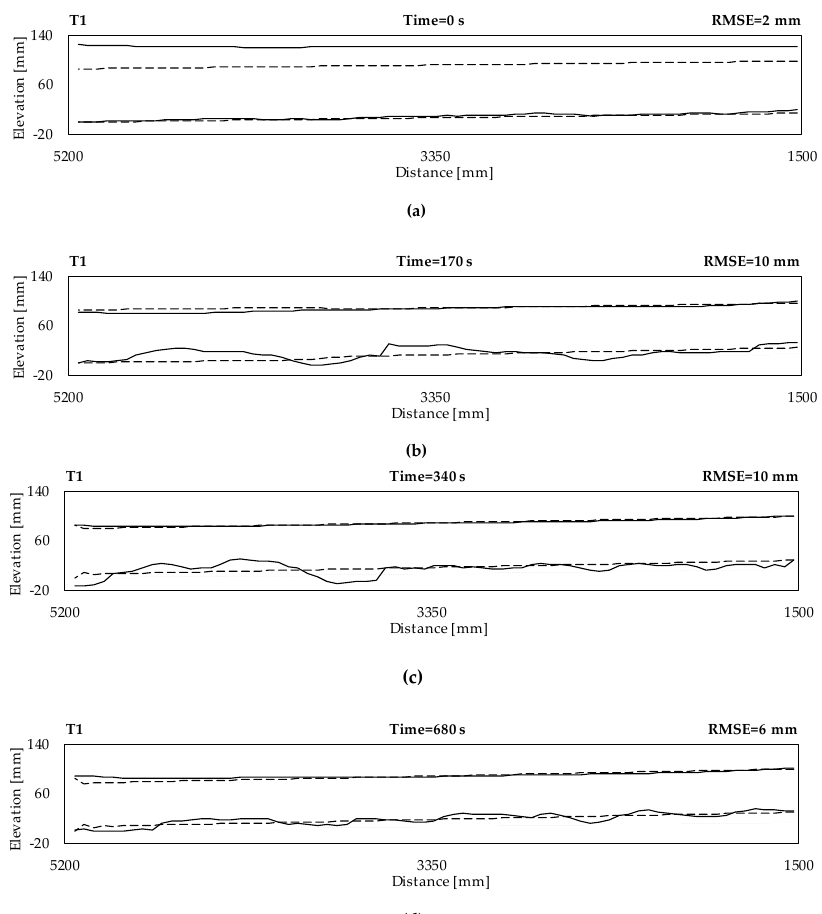
Figure 2. Longitudinal bed and water profiles for the experiment T1 obtained experimentally (continuous) and numerically (dashed) at (a) 0 s, (b) 170 s, (c) 340 s, and (d) 680 s. The horizontal axis represents the stream-wise distance from the inlet, whereas the vertical coordinates were measured with respect to the initial bed surface elevation at the channel outlet. The longitudinal bed profile at 0 s is represented by the gray line. Flow is from right to left.